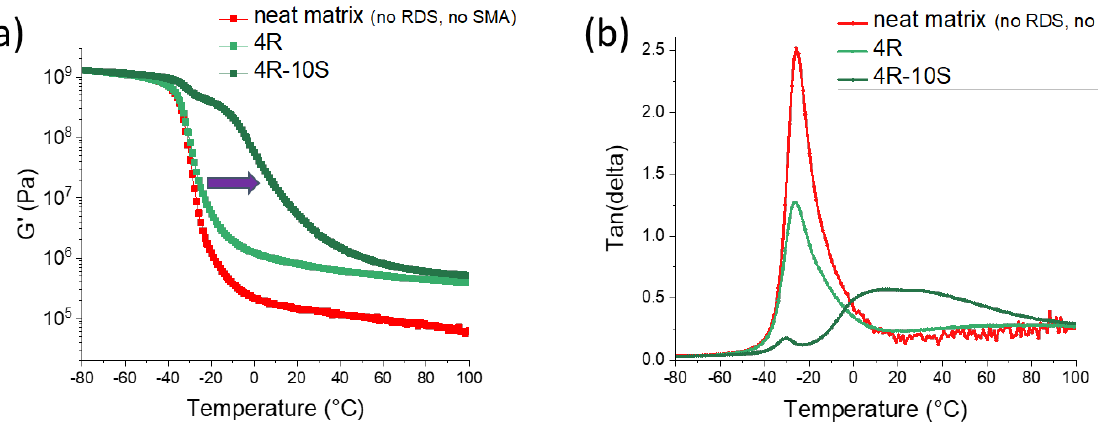
Figure 4. Dynamic-mechanical thermal analysis (DMTA) of neat polyMEA and of selected nanocomposites, namely with 4 wt.% of RDS clay (4R) and with 4% of RDS in addition to matrix doping with 10 mol% of SMA co-monomer (4R-10S): ( a ) curves of the temperature-dependence of storage shear moduli (G’); ( b ) curves of the temperature-dependence of the loss factor (tan(delta)).